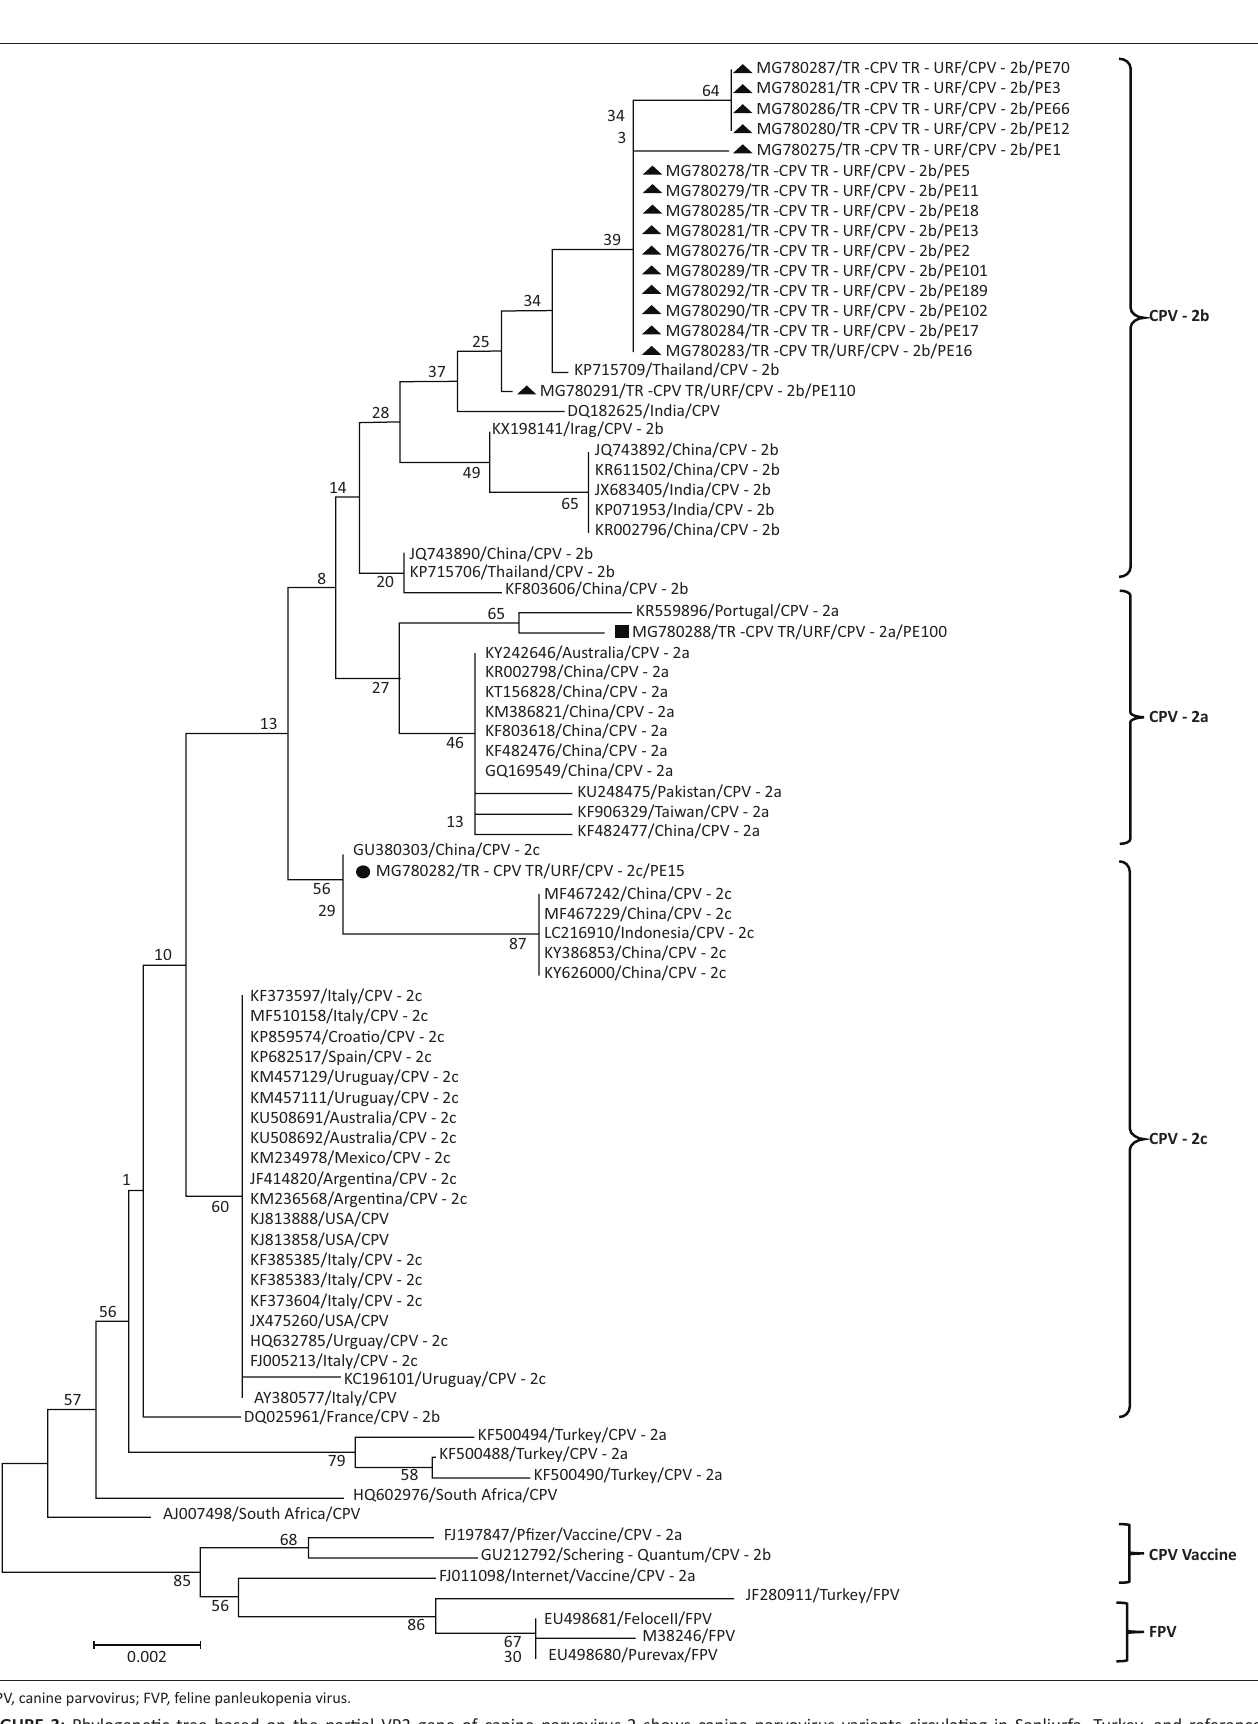
FIGURE 3: Phylogenetic tree based on the partial VP2 gene of canine parvovirus-2 shows canine parvovirus variants circulating in Sanliurfa, Turkey, and reference sequences. The phylogeny was performed neighbour-joining method based on 1000 replicates by MEGA 6 software. Each sequence is indicated with accession number, country and canine parvovirus-2 variants. In this study, canine parvovirus-2a sequence is indicated with ‘ square ’, canine parvovirus-2b sequence is indicated with ‘triangle ’ and canine parvovirus-2c sequence is indicated with ‘ circle